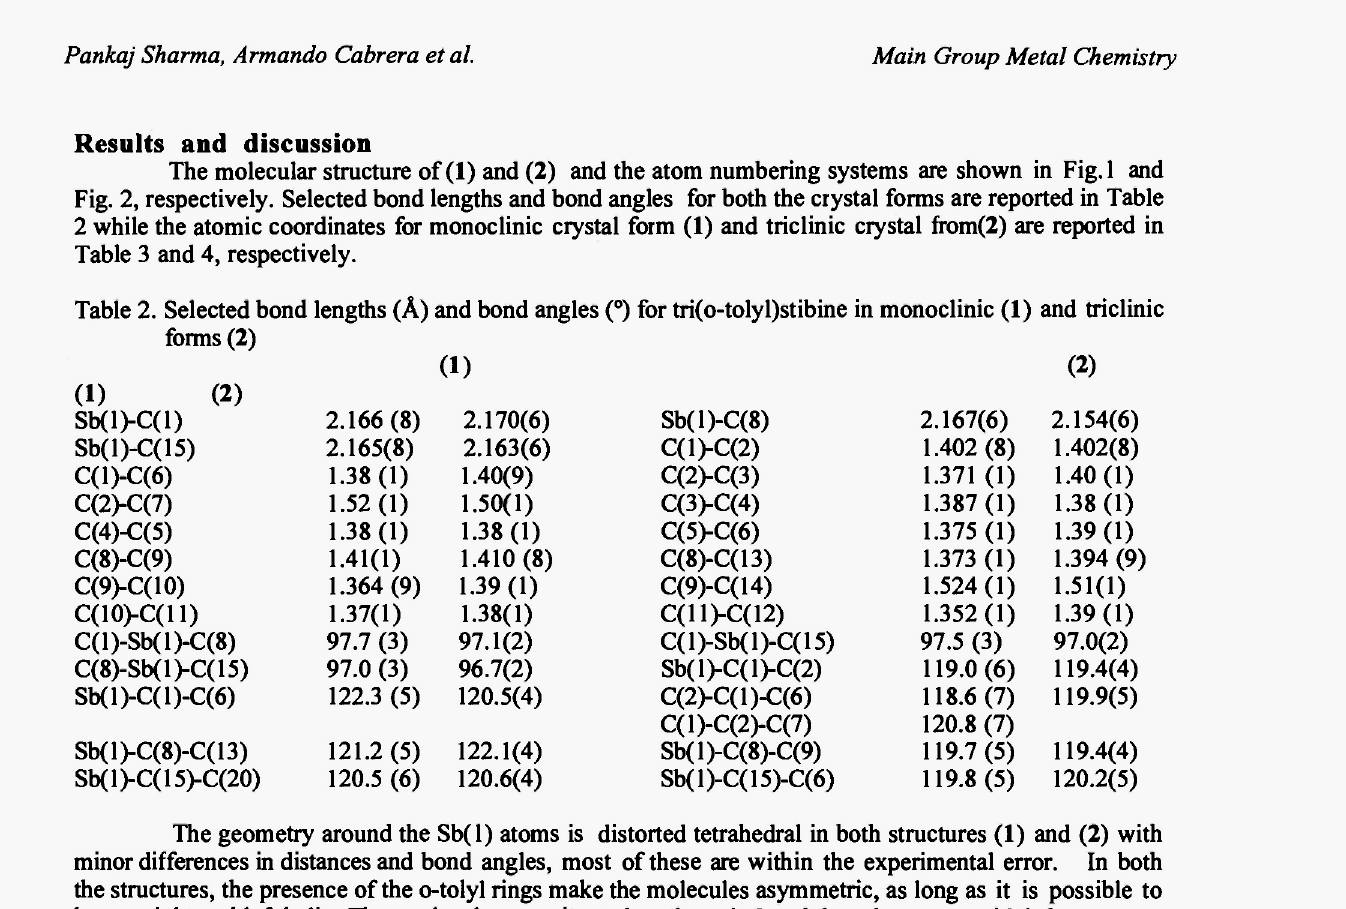
Table 3. Atomic coordinates (xlO^) and equivalent isotropic displacement coefficients (A^xKp) for tri(o-tolyl)stibine in monoclinic crystal form